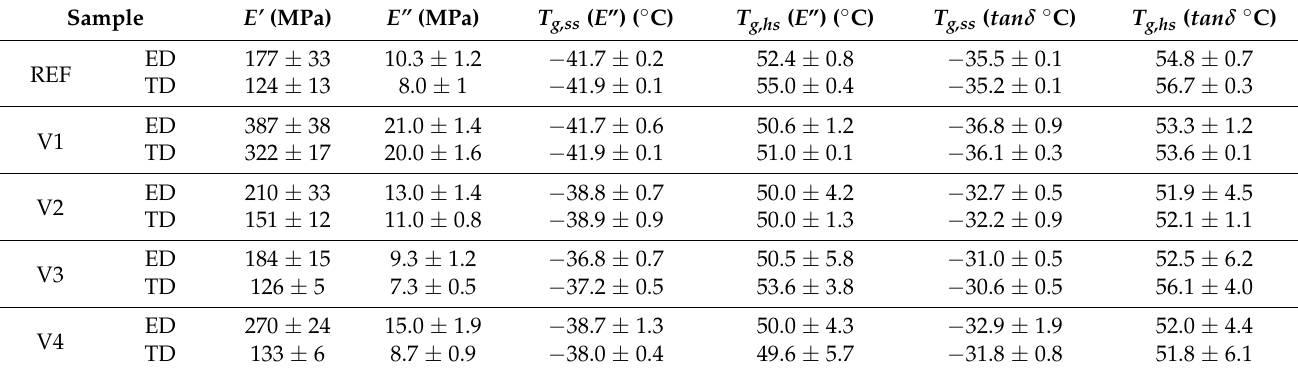
Table 5. The storage moduli E’ and loss moduli E” , glass temperatures of soft segments T g,ss , and glass temperatures of hard segments T g,hs determined using the maxima of E” and tan δ for REF and V1 to V4 compounds measured at 23 ◦ C with a frequency of 1